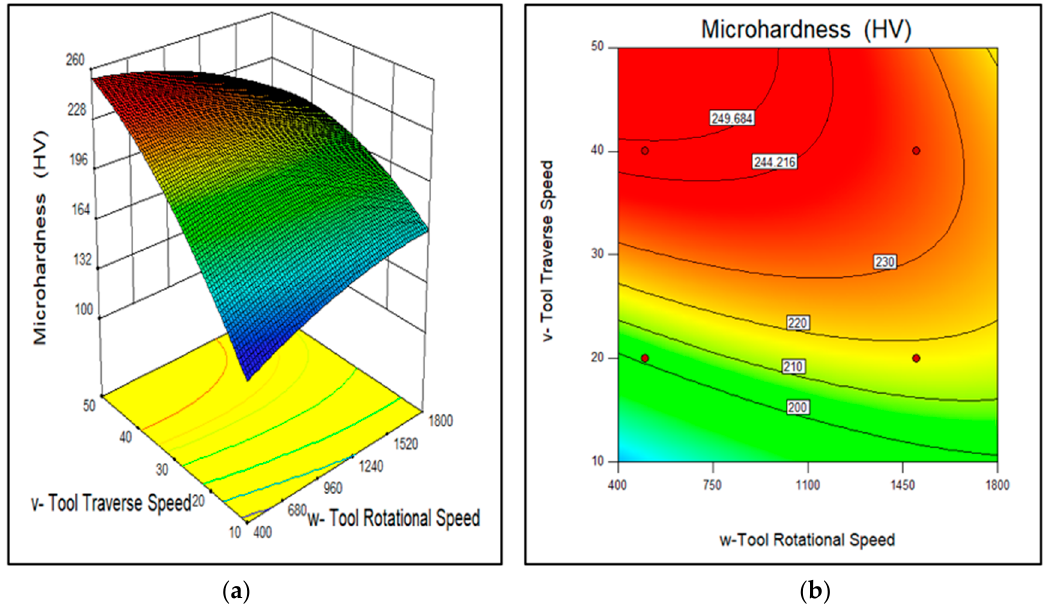
Figure 15. Effect of tool rotational speed and traverse speed on the wear rate of AA7075-SiC/fly ash composites ( a ) 3D surface and ( b ) contour plot.